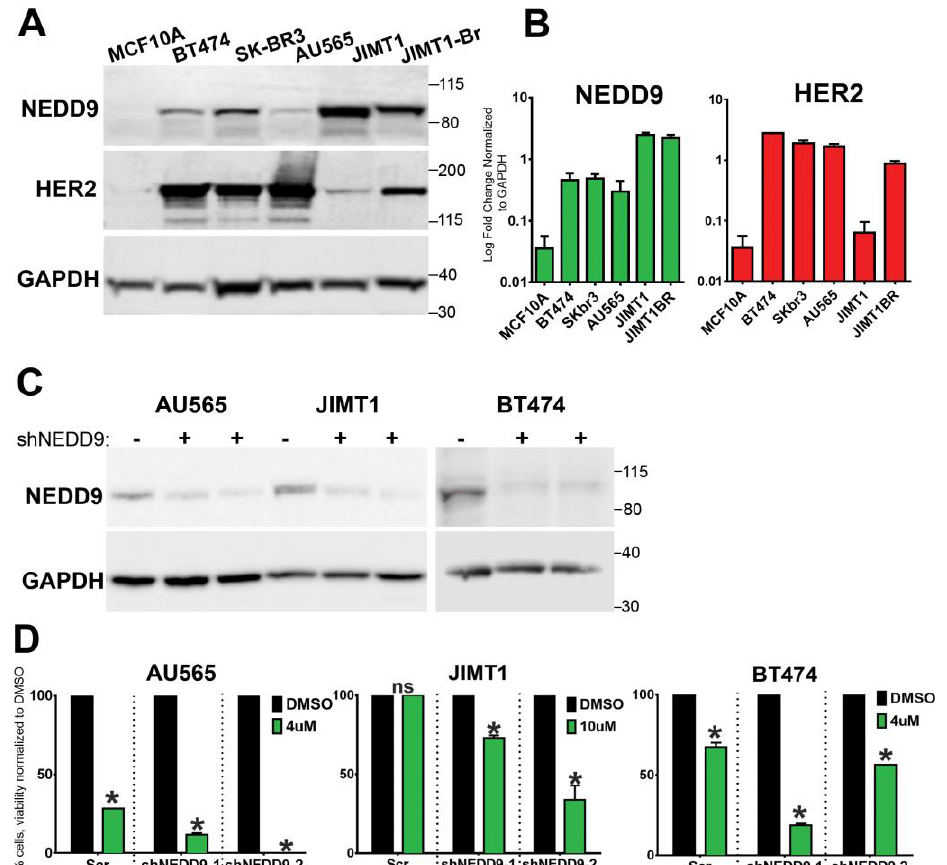
Figure 6. NEDD9 is overexpressed in human HER2+ breast cells and supports resistance to lapatinib. ( A ) Western blot (WB) analysis of MCF10A, BT-474, SK-BR-3, AU565, JIMT-1, and JIMT-1-Br3 (brain metastases subline of JIMT1), using anti-NEDD9, -HER2, and -GAPDH as loading controls. ( B ) WB-based quantification of NEDD9 (green) and HER2 (red) protein expression in cell lines as in ( A ). n = 3 independent experiments. Parson correlation coefficient r = 0.972, with exception of JIMT1, where expression of NEDD9 and HER2 do not correlate. ( C ) Western blot analysis of lysates of AU565, JIMT1, and BT474 cells treated with scramble ( − ) non-targeting control or two different shRNAs against NEDD9 (shNEDD9), using anti-NEDD9 and -GAPDH as loading controls. ( D ) Cell viability assessment using Cyquant dye with different concentrations of lapatinib, as indicated in the figure. Two-way ANOVA, Tukey’s multiple comparison +/ − SEM. AU565, JIMT1, BT474, * p < 0.0001 (DMSO vs. shNEDD-1 or -2), ns — non significant . The original western blots of Figure 6 is Figure S3.